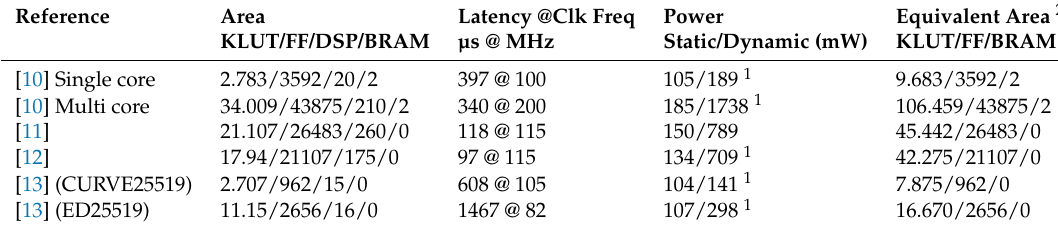
Table 3. Other works implementation